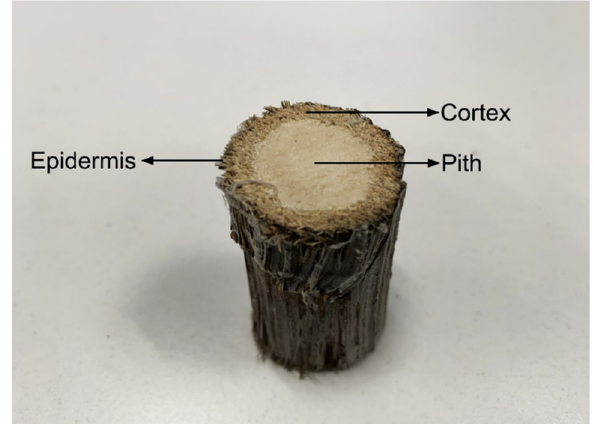
Figure 1. Stalks fraction of cardoon: pith, cortex and epidermis.